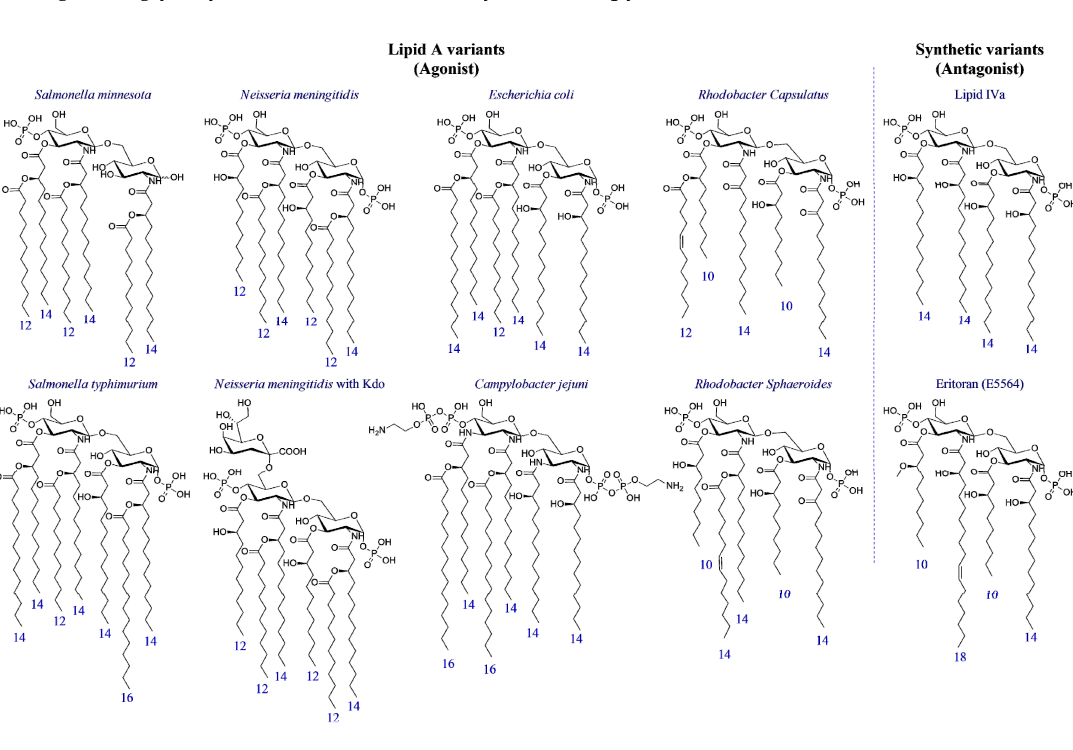
Figure 3. Natural lipid A from Salmonella minnesota , Salmonella typhimurium , Neisseria meningitides (with and without Kdo), Escherichia coli , Campylobacter jejuni , Rhodobacter capsulatus and Rhodobacter sphaeroides ; the biosynthetic lipid A precursor: Lipid IVa and the synthetic molecule Eritoran. The numbers of carbon atoms of each fatty acid chain are displayed in blue.